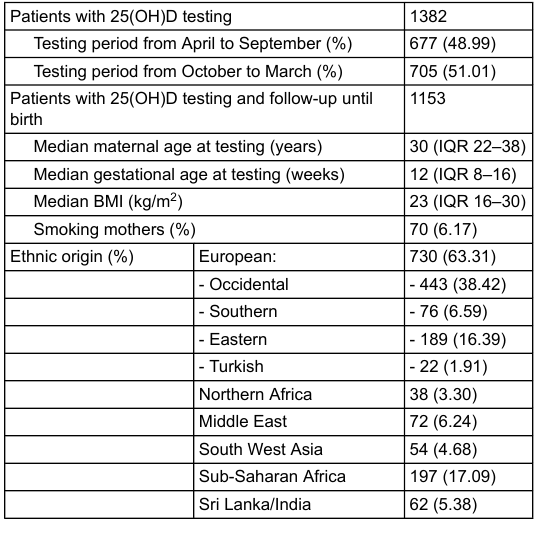
Table 1: Baseline characteristics of the population studied.